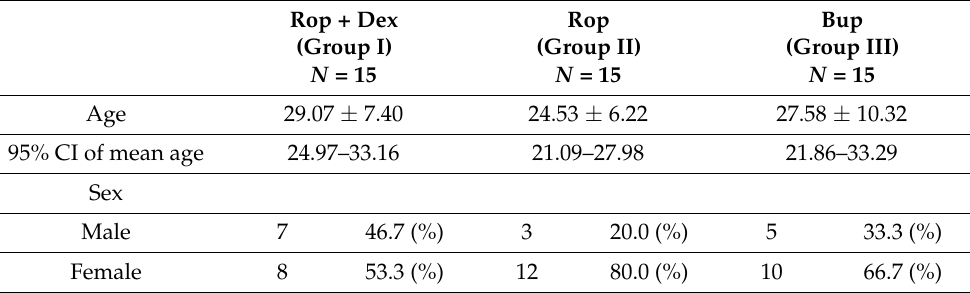
Table 1. Demographics of enrolled patients in the study.